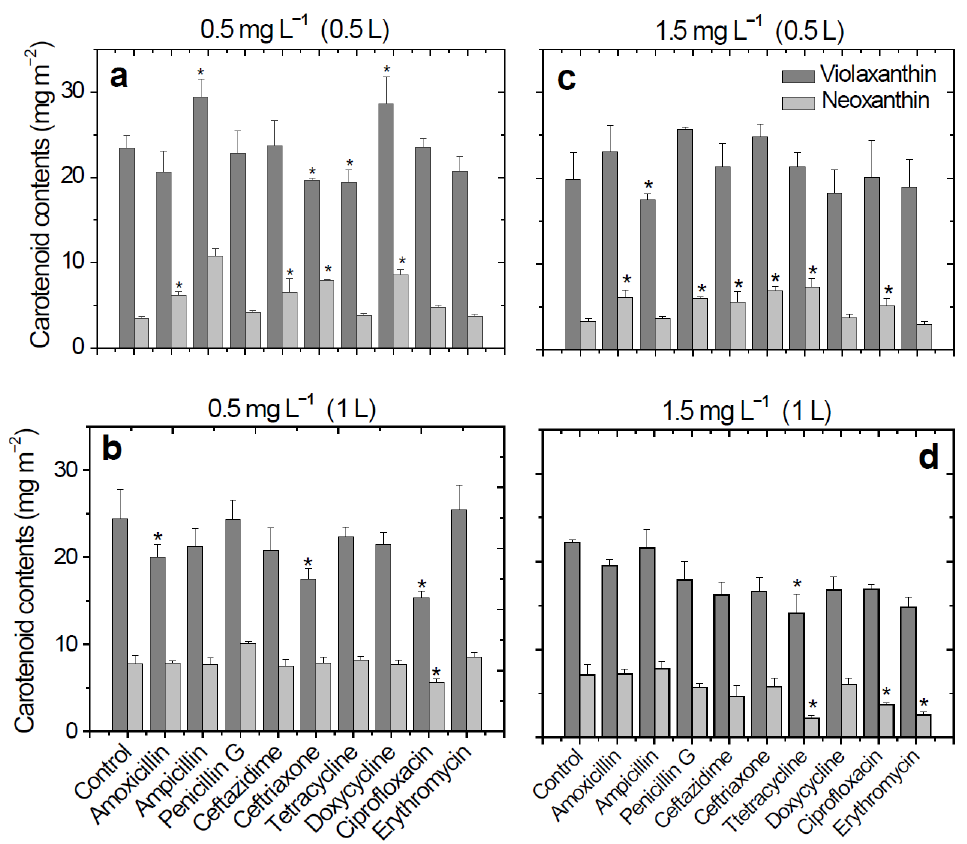
Figure 1. Changes in carotenoid (violaxanthin and neoxanthin) content (mg m − 2 ) in Triticum aestivum L. cv. “Lovrin” plants in response to treatments with nine antibiotics. The plants were watered with a total volume of antibiotic solutions of either 0.5 L (one-week-old plants) or 1 L (two-week-old plants) at a concentration of either 0.5 mg L − 1 ( a , b ) or 1.5 mg L − 1 ( c , d ). Each data point represents the mean (± SEM) of three independent replicate experiments with a different plant. “*” demonstrates statistically significant differences between the given antibiotic treatment and the control ( P < 0.05).